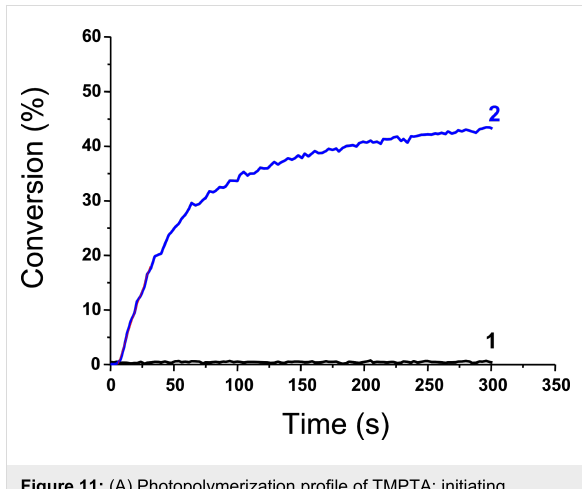
Figure 11: (A) Photopolymerization profile of TMPTA; initiating systems: (1) Ir(piq) 2 (tmd)/MDEA (1%/2%) and (2) Ir(piq) 2 (tmd)/MDEA/R-Br (1%/2%/3%); laser diode at 532 nm; in